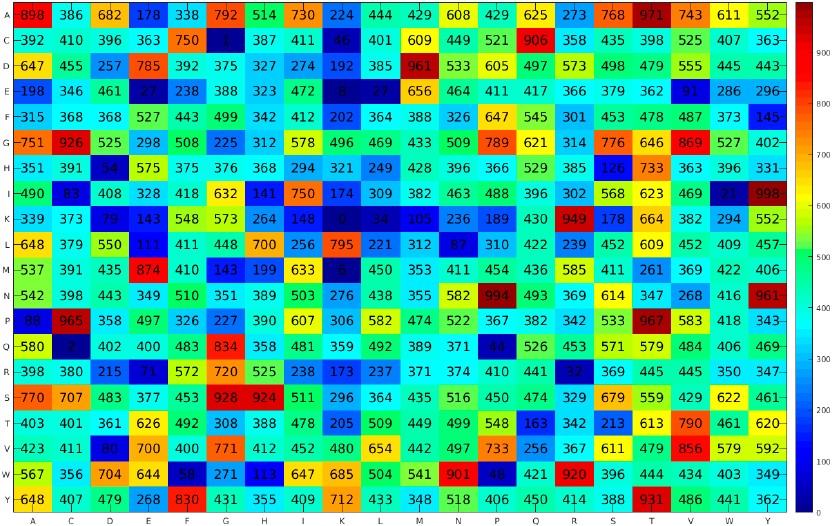
Figure 2. Heatmap of dipeptide propensity scores obtained from the PVPred-SCM method.